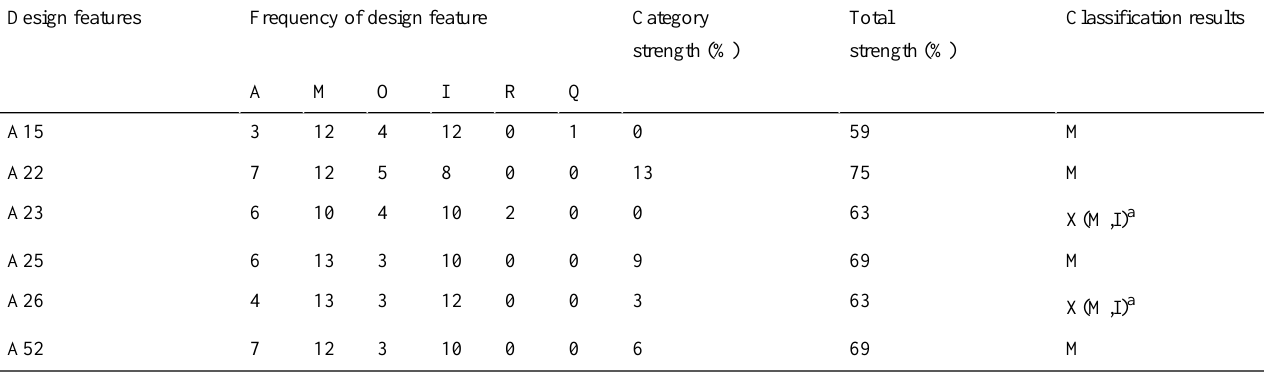
Table 9. Categorizing design features by medium self-efficacy participants (n=32).